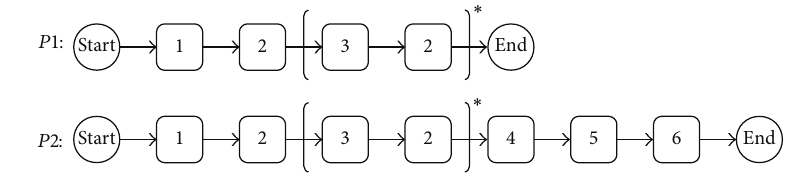
Figure 6: Example system path